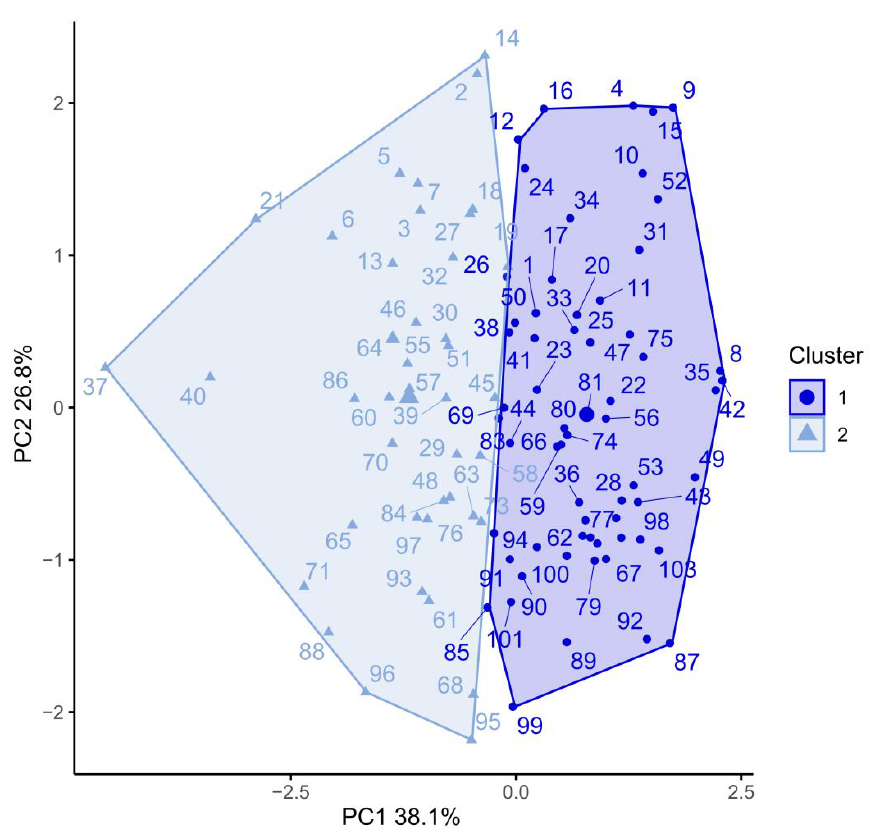
Figure 4. Principal component (PC) analysis for the clusters formed, according to the potassium, phosphorus, and nitrogen content of the soybean genotypes (numbers of 1 to 103) using the k-means algorithm.